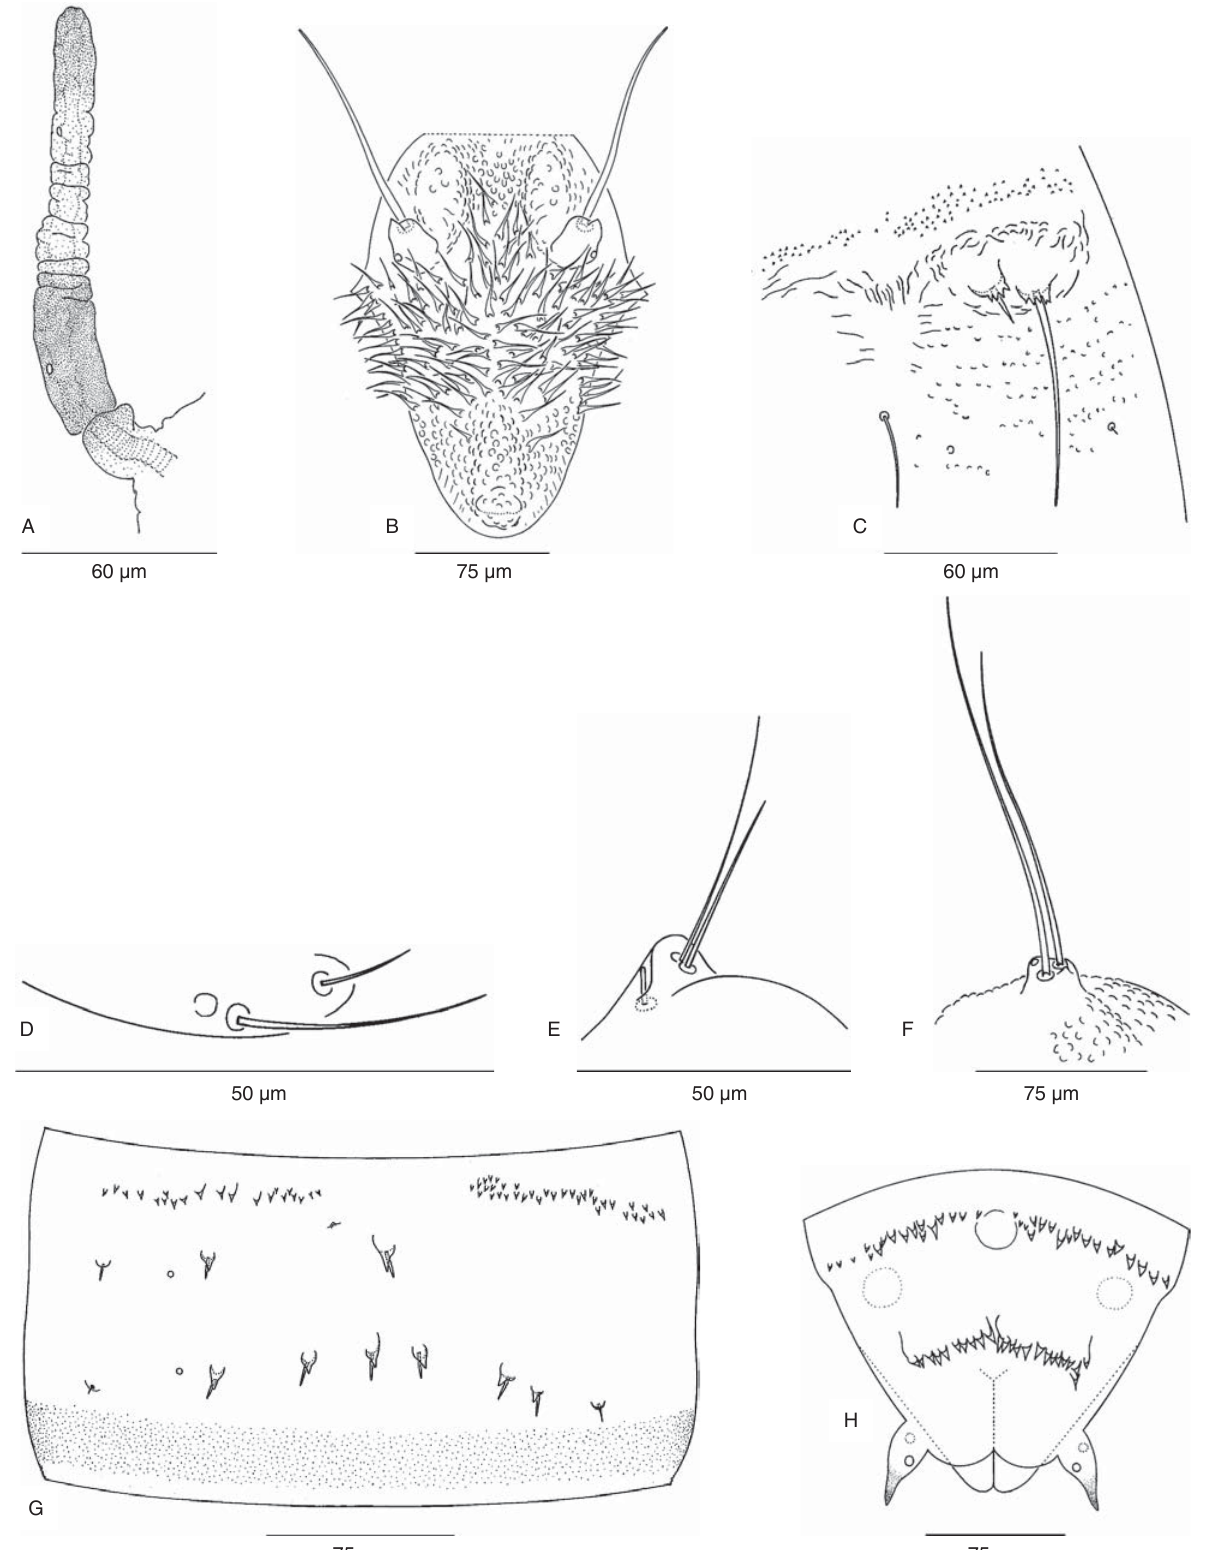
FIG. 2 The pupa of Culicoides bolitinos : (A) prothoracic respiratory organ; (B) ♂ operculum; (C) thorax; (D) ventrolateral setae (vl); (E) dorsolateral tubercle (dl); (F) anterodorsal tubercle (ad); (G) fourth abdominal segment; (H) caudal